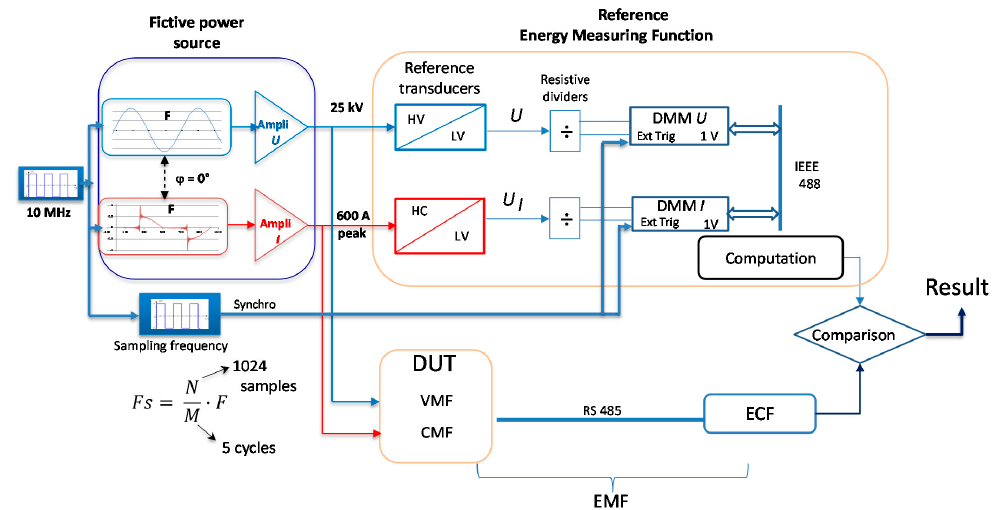
Figure 1. Design principle of energy measurement systems (EMS) calibration setup developed by LNE.